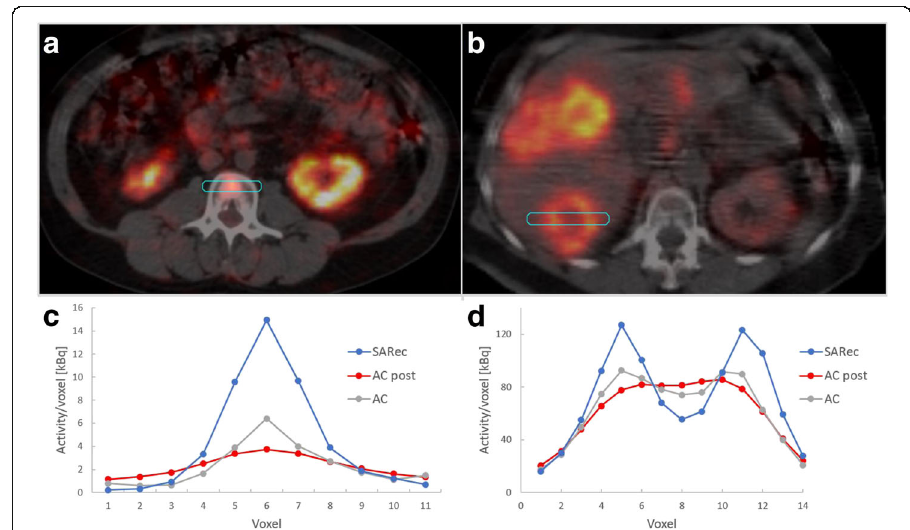
Fig. 6 Transverse sections of SARec reconstructed images with line profiles through a bone marrow uptake ( a , c ) and a liver tumor with non-uniform uptake ( b , d ). The line profiles show the uptake profiles for SARec (SARec) and AC-OSEM (AC) post-filtered AC-OSEM (AC post) reconstructed